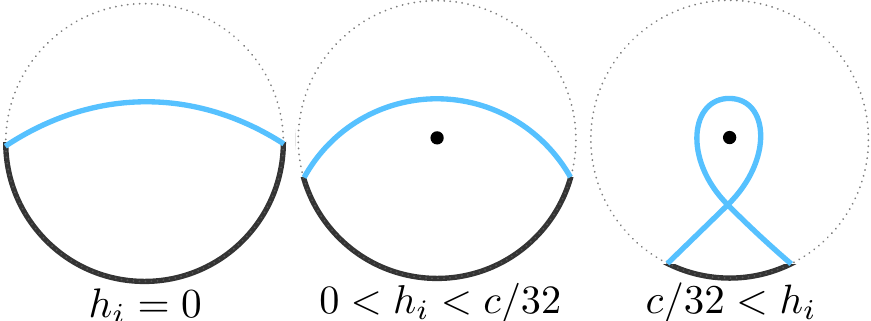
Figure 7 . Time slices of global AdS 3 with a brane (shown in blue) and a conical defect (the black dot at the center). The conical defect is created by inserting scalar primaries with conformal dimension h = ¯ h at two infinities in the BCFT dual. When h i i around the conical defect will exceed π , and the brane will intersect